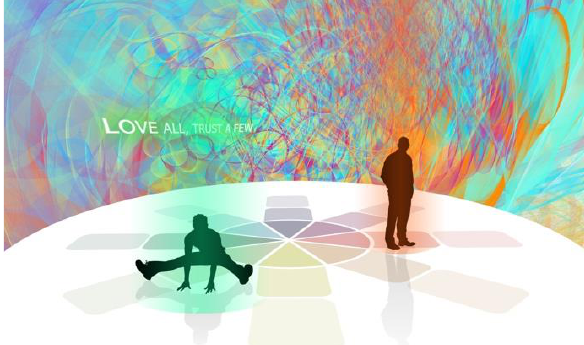
Figure 4 | A simplified vision of the stage/performance. The character on the left is using the trust space. The generative scenario behind him shows mainly lower plane activity and smaller forms, according to his spatial placement, whereas the character on the left is causing more disturbances (in colour, frequency and form) since he is standing, therefore using the higher planes, on the anger space. Source: